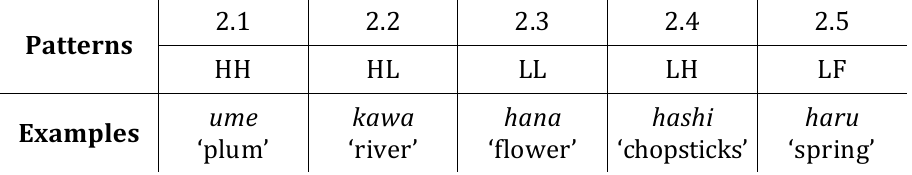
Table 3: Japanese pitch accent in disyllabic nouns (H = high tone, L = low tone, F = falling tone)